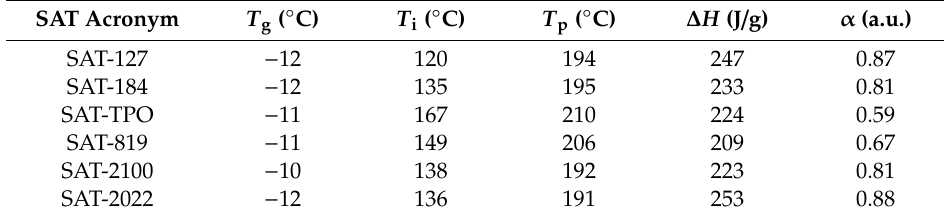
Table 5. Thermal features of uncured self-adhesive tapes (SATs) based on ASs and cross-linking degree of cured SATs.